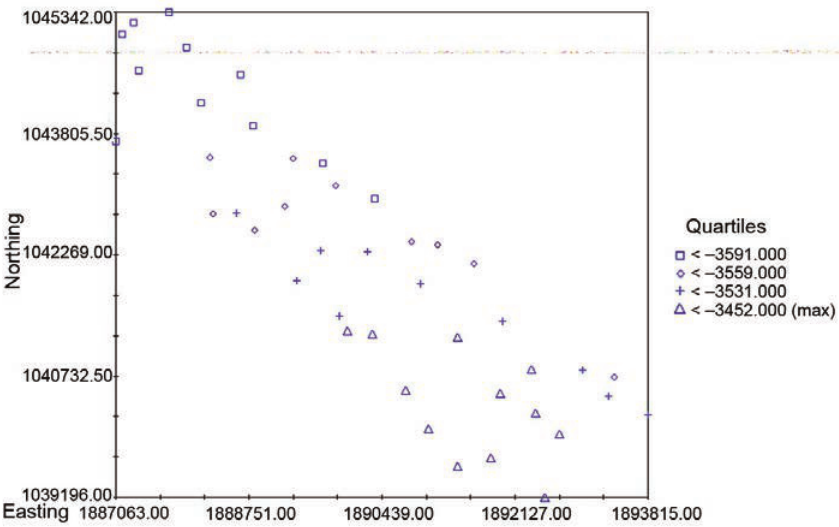
Fig. 1. Location of wells in the